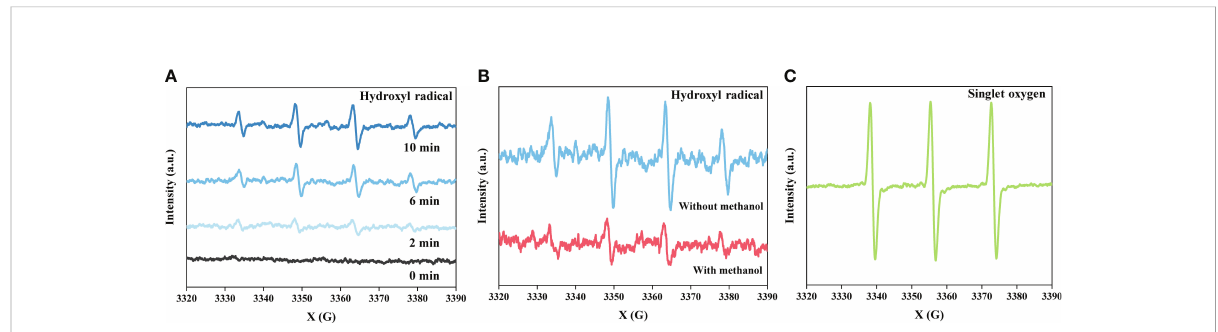
FIGURE 7 (A) EPR spectra of DMPO-hydroxyl radical adducts as a function of treatment time, (B) the spectra from with or without methanol contained water, and (C) the spectrum of TEMP-oxygen radical adducts at a frequency of 20 kHz and a pulse width of 2 m s. This shows quantitative comparison of the amount of hydroxyl radical and a possibility to achieve enhanced performance of liquid phase plasma in real wastewater which has no scavengers. Contribution of oxygen radical to oxidation was also veri fi